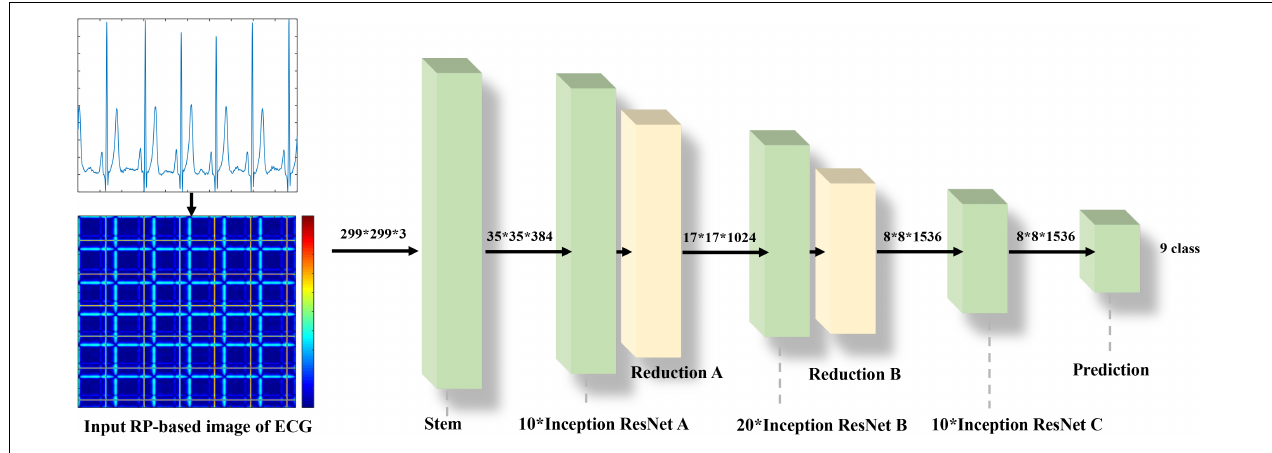
FIGURE 6 | The workflow of the proposed approach for CA classification.